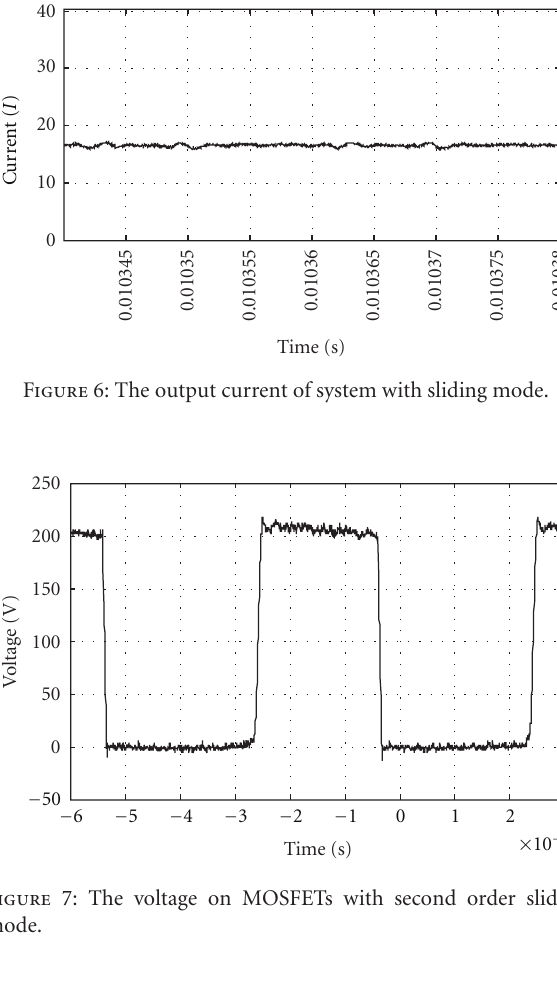
Figure 5: The output voltage of system with sliding mode. Table 1: Experimental parameters.